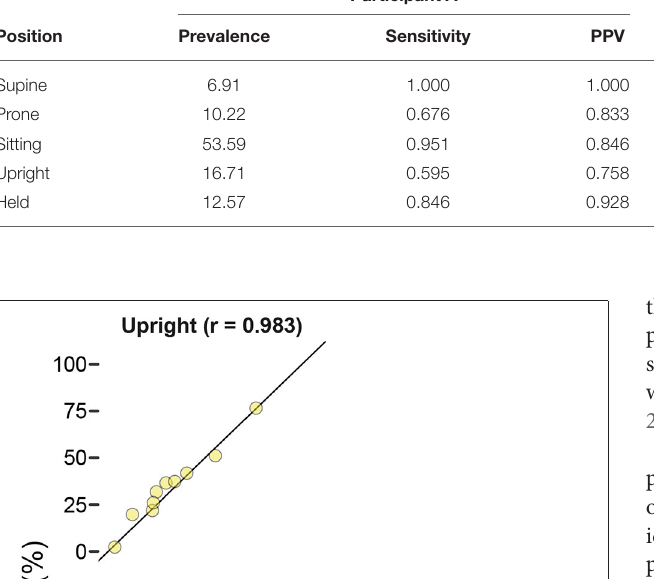
TABLE 3 | Prevalence, sensitivity, and positive predictive value (PPV) by body position for the testing datasets used to assess case studies (Participants A and B). Participant A